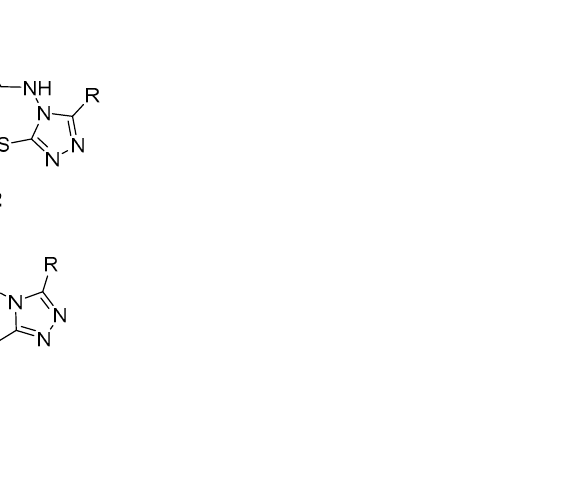
Figure 5. Model ( 1 , 2 ) and target ( 6 , 8 ) compounds: 5-substituted 4-((3-phenylprop-2-yn-1-ylidene)amino)-4 H -1,2,4-triazol-3-thiols 1 and 5-substituted 4-((3-phenylprop-2-yn-1-yl)amino)-4 H -1,2,4-triazole-3-thiols 2 , 3-substituted ( Z )-7-benzylidene-7 H -[1,2,4]triazolo[3,4- b ][1,3,4]thiadiazines 6 , 3-substituted ( Z )-7-benzylidene-6,7-dihydro-5 H -[1,2,4]triazolo[3,4- b ][1,3,4]thiadiazines 8 . 4-amino-4 H -1,2,4-triazole-3-thiols 4 . However, prior to our studies, only one article on the